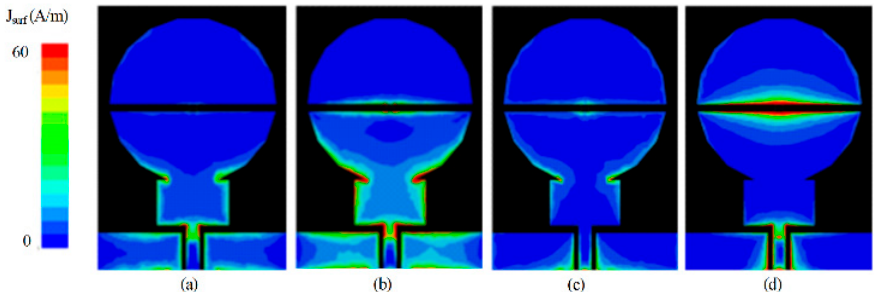
Figure 4. Distribution of current density on the surface of antenna at ( a ) 3.75 GHz [diode-OFF], ( b ) 3.75 GHz [diode-ON], ( c ) 6.5 GHz [diode-OFF], and ( d ) 6.5 GHz [diode-ON]. Comparison among the various steps included in the antenna